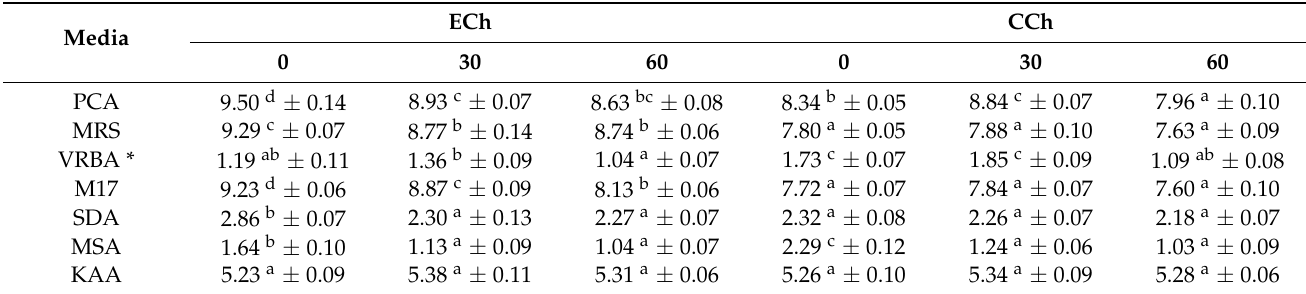
Table 4. Microbial counts expressed as log 10 cfu/mL and standard deviation (SD) of the main microbial groups detected in experimental (ECh) and control (CCh) cheeses at 0, 30 and 60 days of ripening. Media